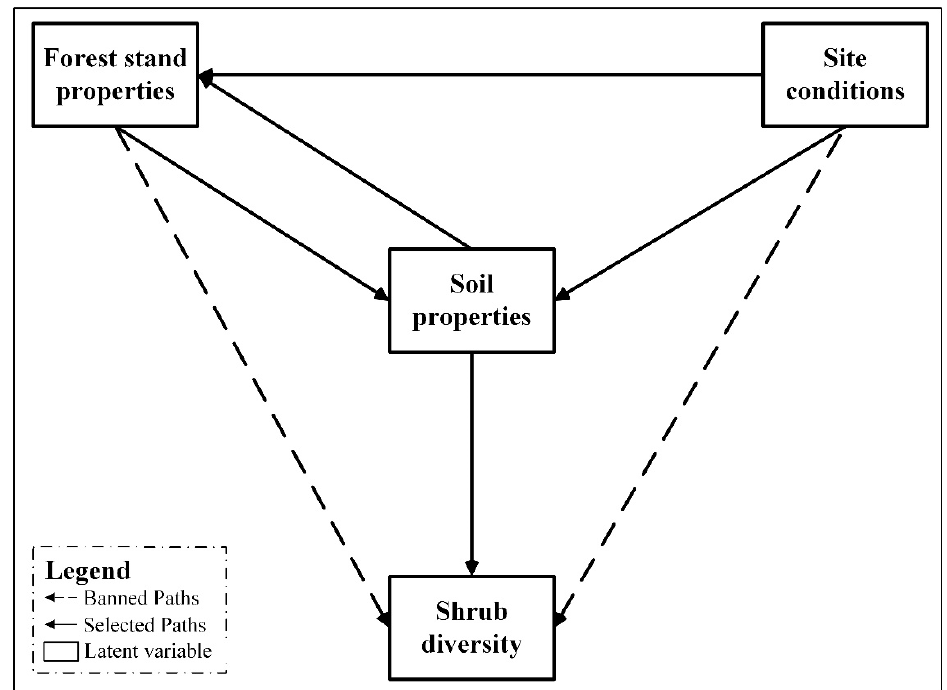
Figure 4. Secondary model based on CCA result.